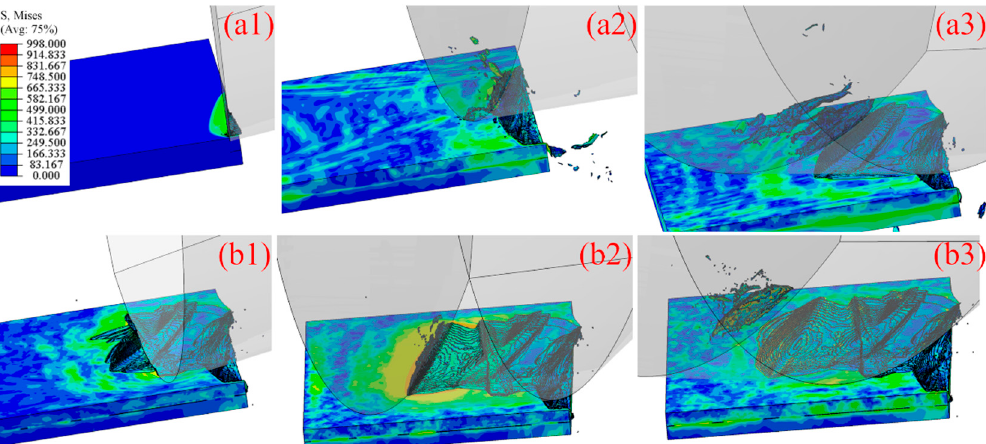
Figure 5. FE simulation of the chip formation process during diamond milling in the ( top ) first and ( bottom ) second rotation cycle. ( a1 ) and ( b1 ) Initial tool-workpiece contact, ( a2 ) and ( b2 ) Generation of chips, and ( a3 ) and ( b3 ) Tool-chip separation.